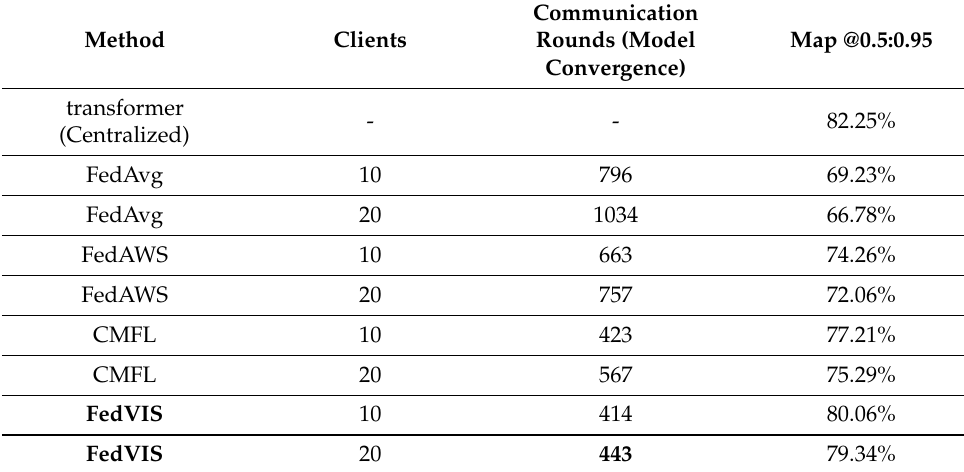
Table 3. Comparison of detection performance under the Non-IID distribution. As the number of clients increases, the accuracy achieved by the other algorithmic models shows a decrease and the number of communication rounds required increases significantly, while our method can still maintain a better detection